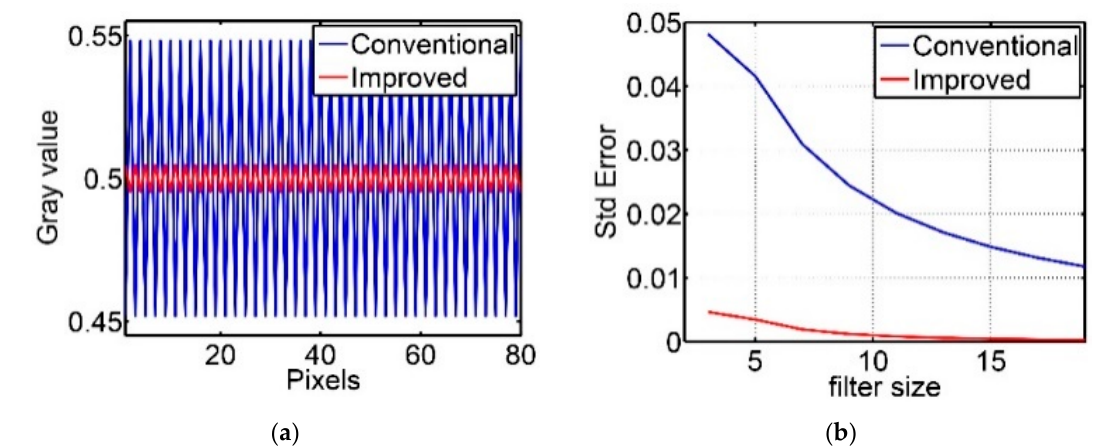
Figure 4. ( a ) The cross sections for the intermediate gray level; ( b ) Rms error under different defocusing levels.